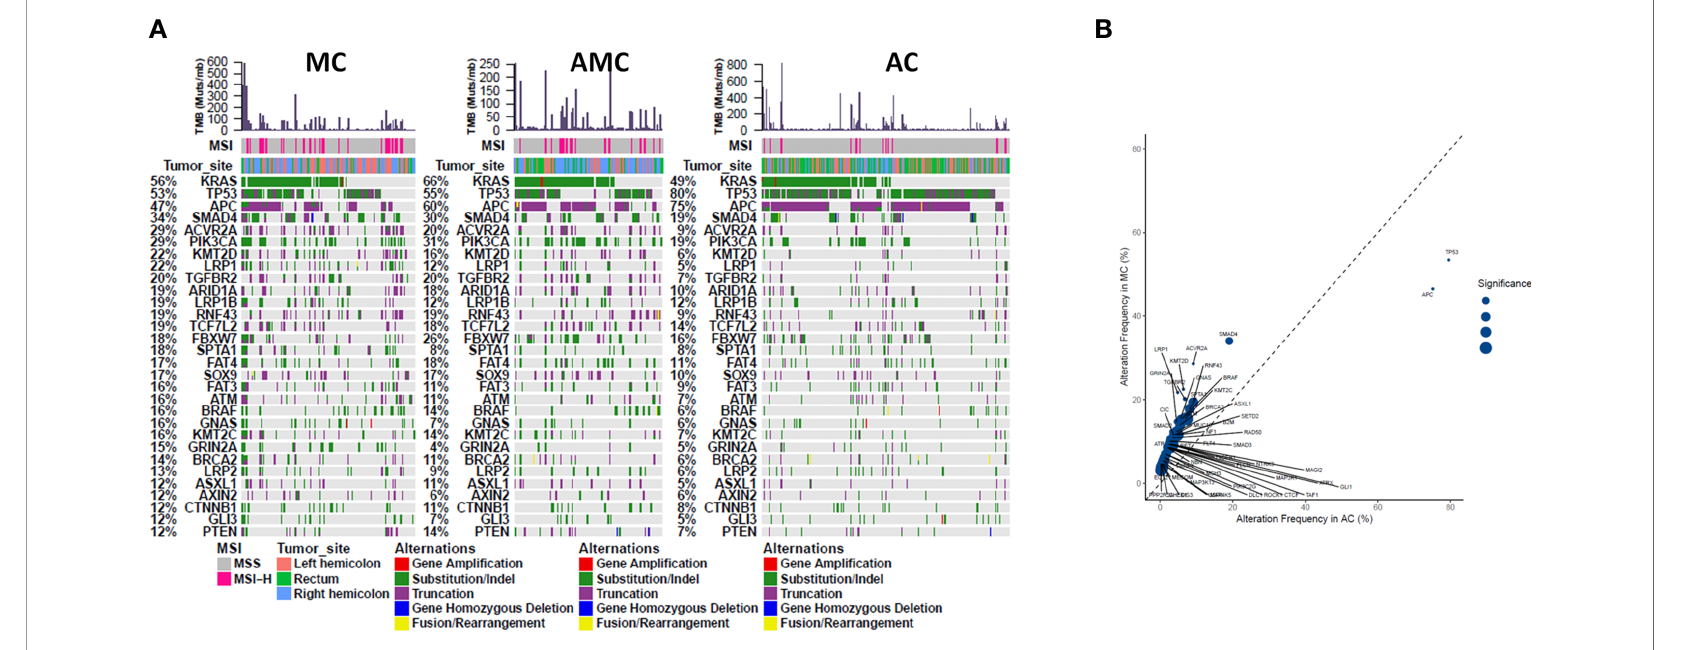
FIGURE 1 | Comparison of common gene mutations in MC, AMC, and AC. (A) Genomic landscape showing mutated genes among MC, AMC, and AC. Each column denotes an individual tumor and each row represents the MSI status, tumor site, and individual genes. Colors indicate the type of genetic alterations as indicated in the legend. (B) Analysis of the gene alteration frequency showing a higher gene alteration frequency in the MC group. MC, mucinous carcinoma; AMC, adenocarcinoma with mucous composition; AC, adenocarcinoma; MSI, microsatellite